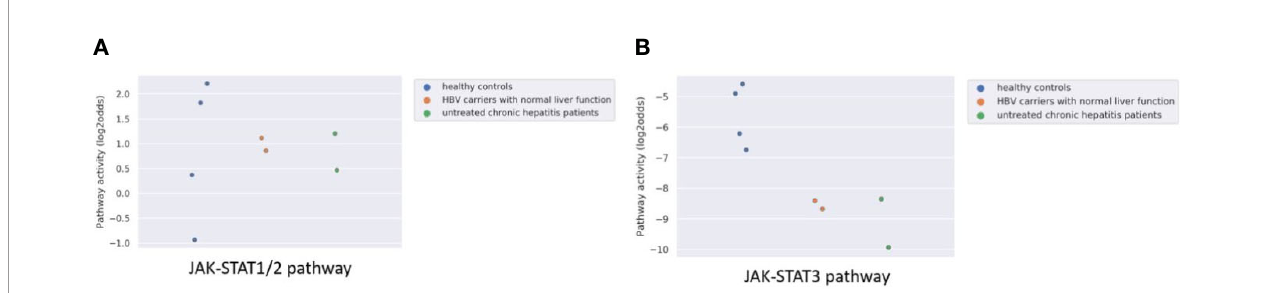
FIGURE 5 | JAK-STAT1/2 (A) and STAT3 (B) pathway activity analysis of dataset GSE119322 (39) including HBV patients with normal liver function, untreated chronic hepatitis patients and healthy controls. Mononuclear cells were isolated and the plasmacytoid DCs (pDCs) were used for analysis. Pathway activity score on Y-axis